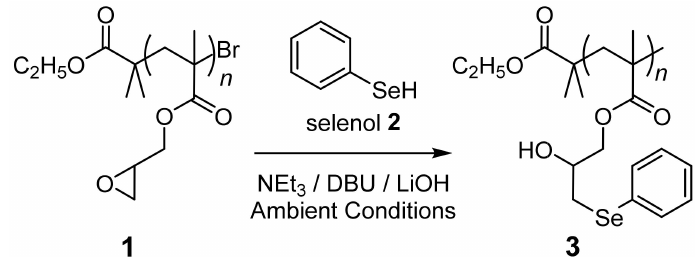
Scheme 1. Base-catalyzed ring-opening of side-chain epoxides in poly(glycidyl methacrylate)s through selenium-epoxy